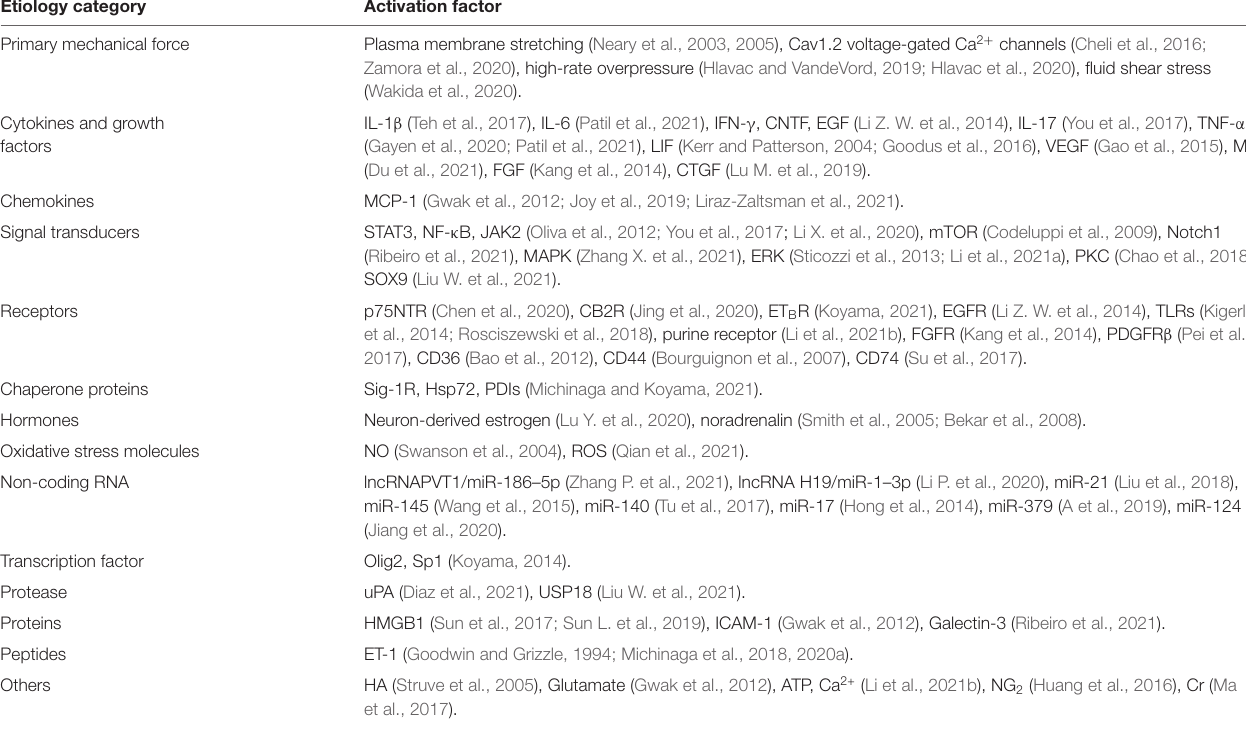
TABLE 1 | Molecules and signaling pathways that involved in the activation of